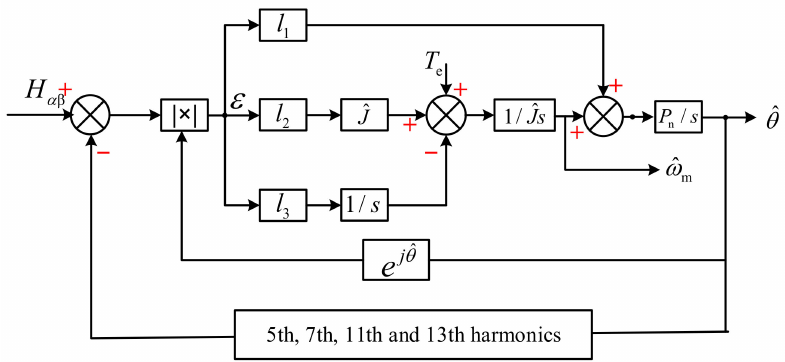
Figure 8. Block diagram of Luenberger observer with feedback decoupling.